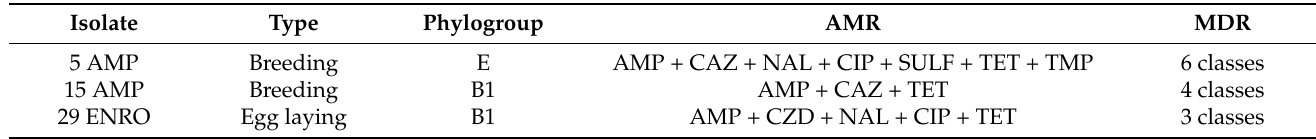
Table 6. Characteristics of isolates positive for resistant ESBL